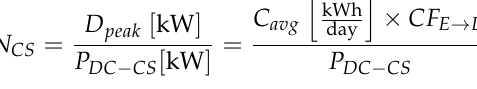
Figure 20. Power demand scenarios. 4.7. Number of Charging Stations in the Facility to Meet Demand Scenarios of Campinas The number of stations to meet expected peak demand scenarios can be estimated as a function of the peak rated power provided by each charging station. The peak demand value can be determined by applying a conversion factor from average daily consumption to demand, as presented in Equation (9). 𝑁 𝐶𝑆 = 𝐷 𝑝𝑒𝑎𝑘 [kW] 𝑃 𝐷𝐶−𝐶𝑆 [kW] = 𝐶 𝑎𝑣𝑔 [kWh day ] × 𝐶𝐹 𝐸→𝐷 𝑃 𝐷𝐶−𝐶𝑆